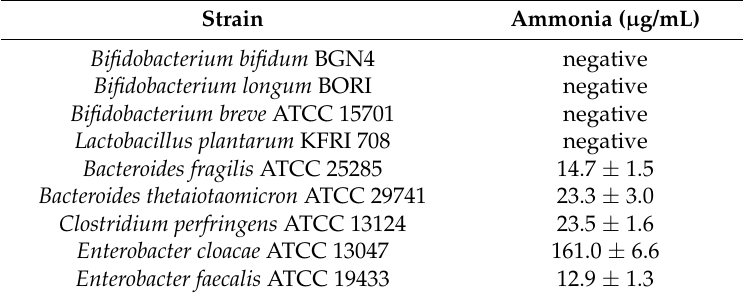
Table 1. Mean value and standard deviation of ammonia level variables of B. bifidum BGN4, B. longum BORI, and other commercial microorganisms ( n = 3).